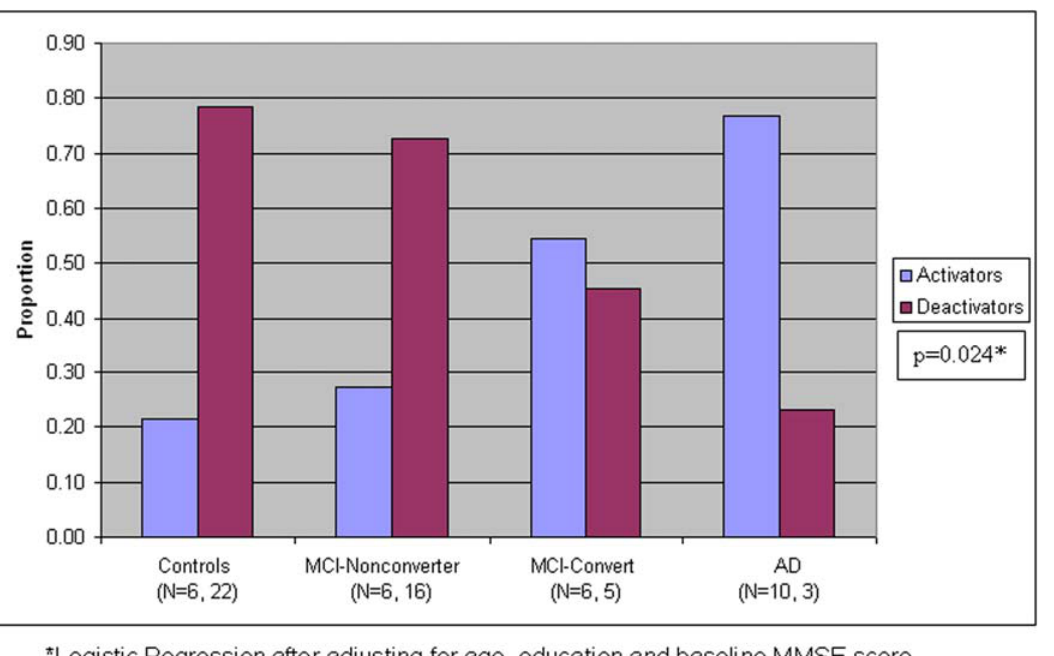
Figure 2. Bar graph demonstrates the proportion of activators and deactivators among the four diagnostic groups. The proportion of deactivators was significantly different (p , 0.05) across diagnostic groups after adjusting for age, education and baseline MMSE score, with significantly fewer deactivators with increasing cognitive impairment grouping.